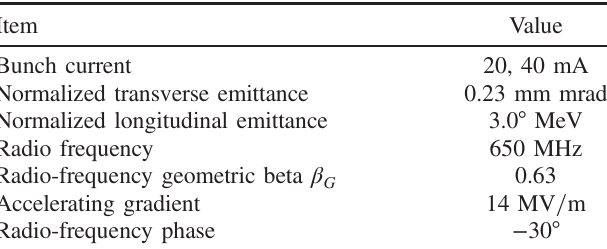
TABLE I. Parameters used for double-pass proton LINAC design. Bunch current represent the average current over a single rf bucket.